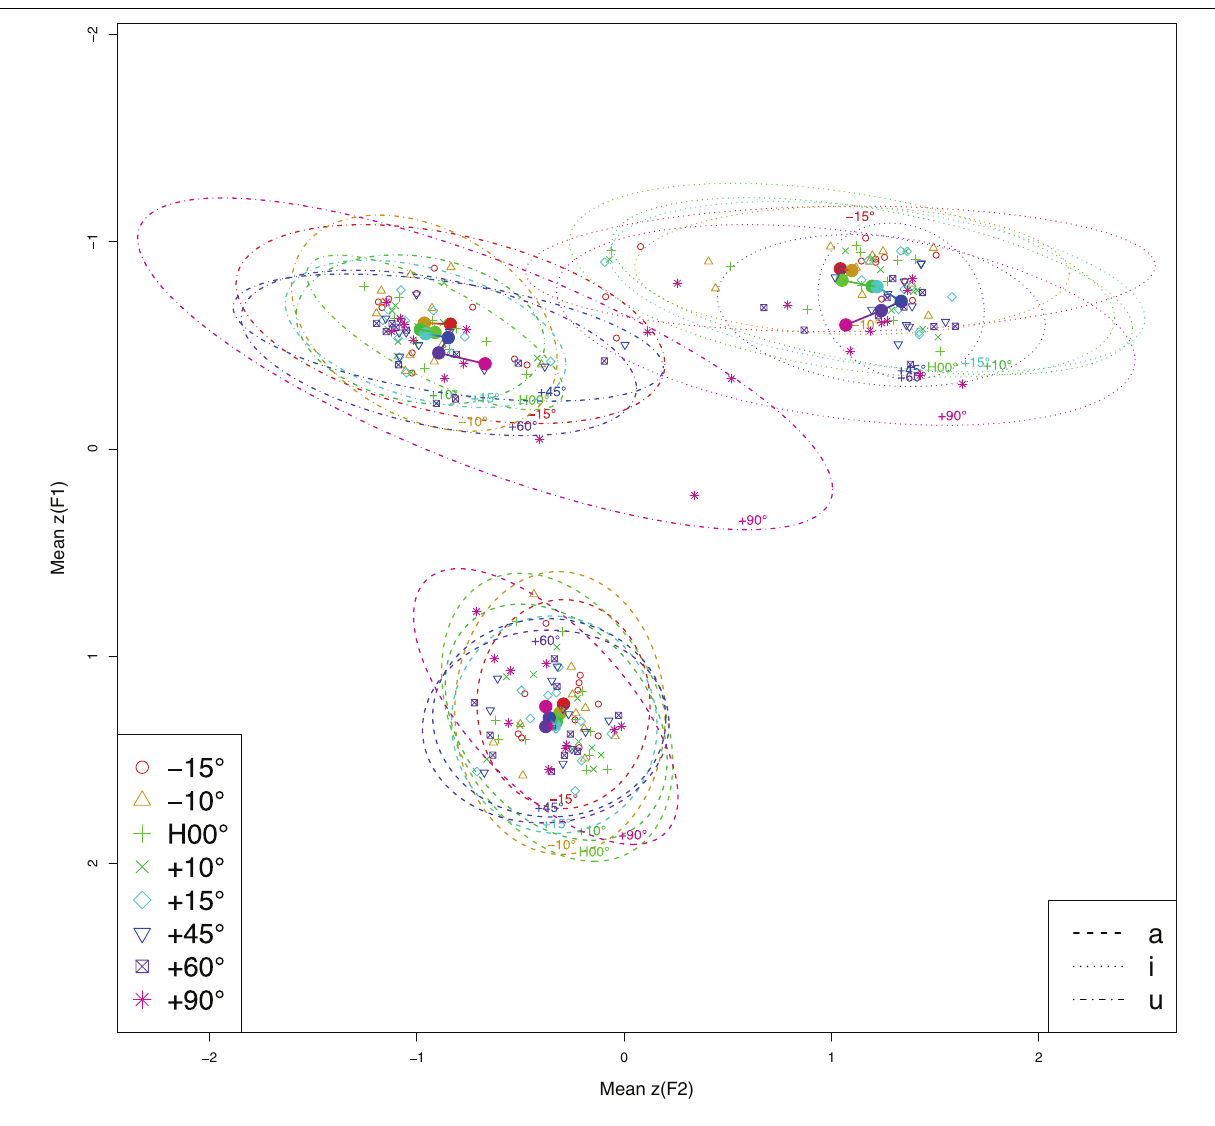
FIGURE 1 | Averaged formants ( F 1 ∼ F 2, in z -score) across different head angels (color-coded) for all three vowels (line type separated). Hollow circles represent the averaged formants for individual speakers; solid circles represent the averaged formants across all speakers at each head angle. Ellipses enclose 95% of the normal probability density function (color